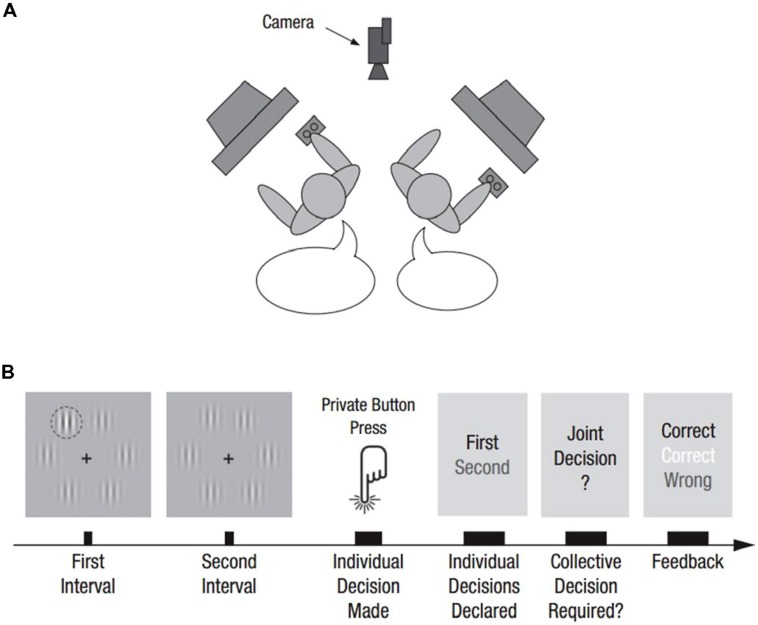
(A) Schematic of optimally interacting minds experimental setup. (B) Progress of sample trial (from Fusaroli et al., 2012).